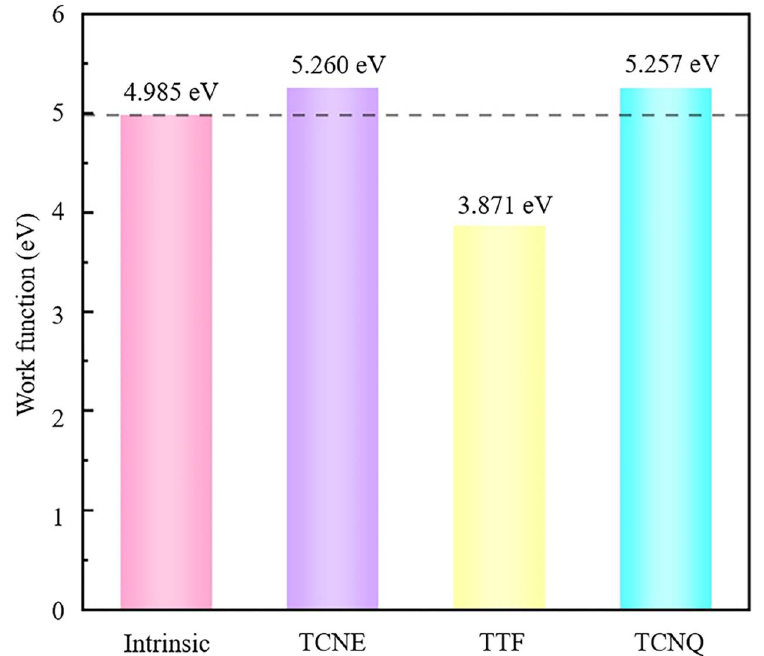
Figure 4. The work function of g−ZnO adsorption by organic molecules.